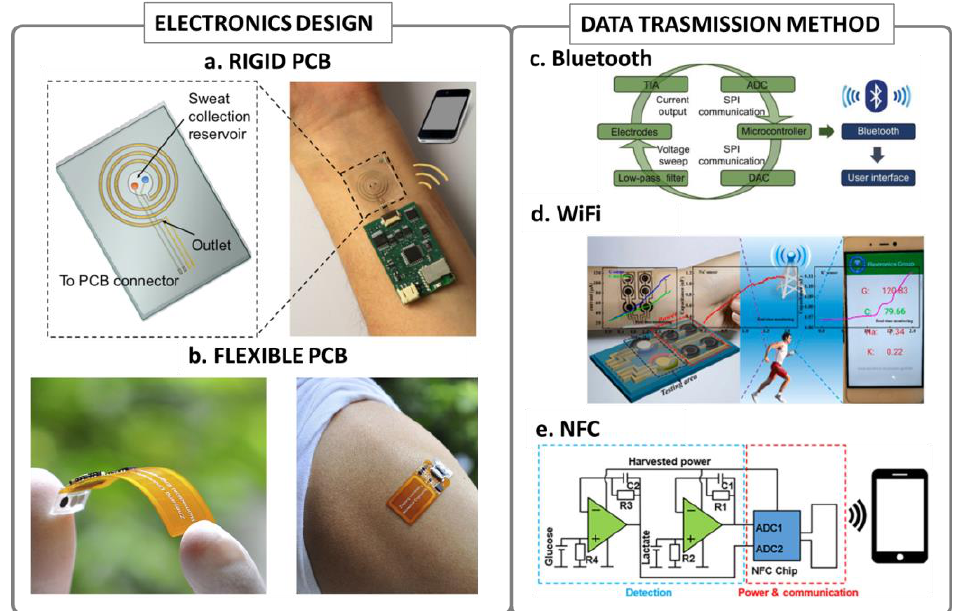
Figure 2. Wearable electronics design and connectivity: ( a ) example of a wearable device with rigid PCB electronics, reproduced with permission from [31], copyright 2018, American Chemical Society; ( b ) example of a flexible polyimide circuit integrated in a wearable sensing device, reproduced with permission from [29], copyright 2020 Elsevier; ( c ) typical block scheme of a Bluetooth-based wearable device, reproduced with permission from [33], copyright 2018 WILEY-VCH Verlag GmbH & Co. KGaA, Weinheim; ( d ) typical block scheme of a WiFi-based wearable device, reproduced with permission from [47], copyright 2019 Elsevier; ( e ) typical example of an NFC-based wearable device block scheme, reproduced from [45], open